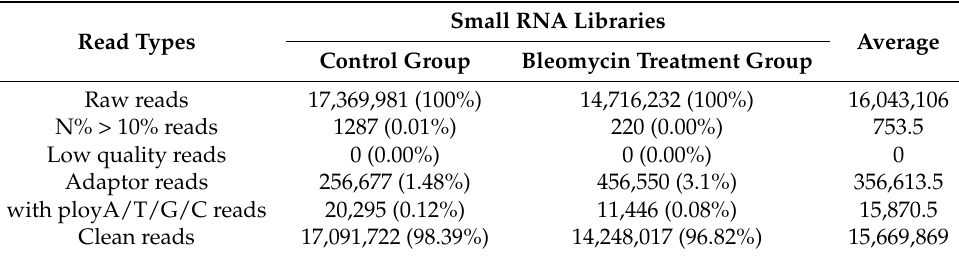
Table 2. Classification of small RNAs identified in rice